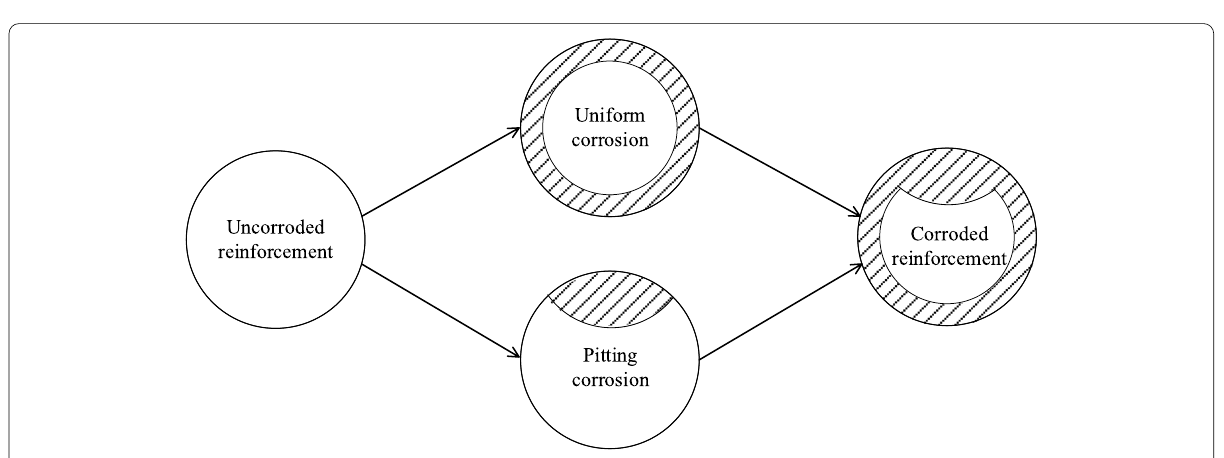
Fig. 2 Uniform and pitting corrosion, hatching indicates corroded